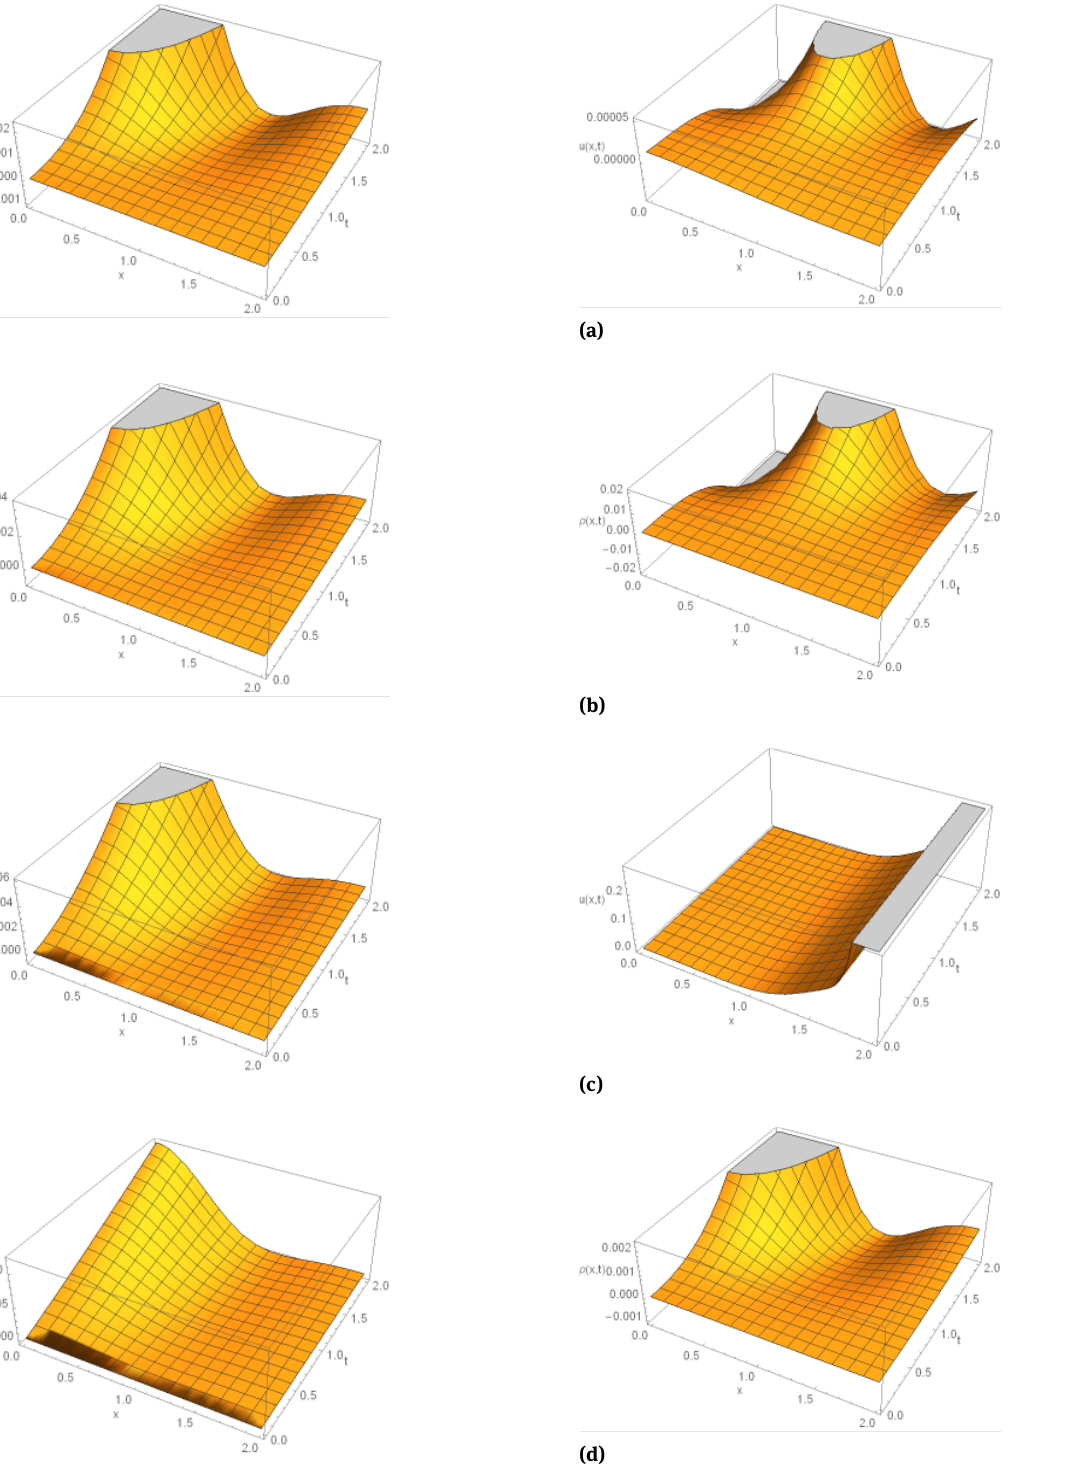
Figure 4: The surface graph of approximate solution ρ ( x , t ) for case- II: (a) ρ ( x , t ) for β = 1 (b) ρ ( x , t ) for β = 0.8 (c) ρ ( x , t ) for β = 0.6 (d) ρ ( x , t ) for β = 0.4